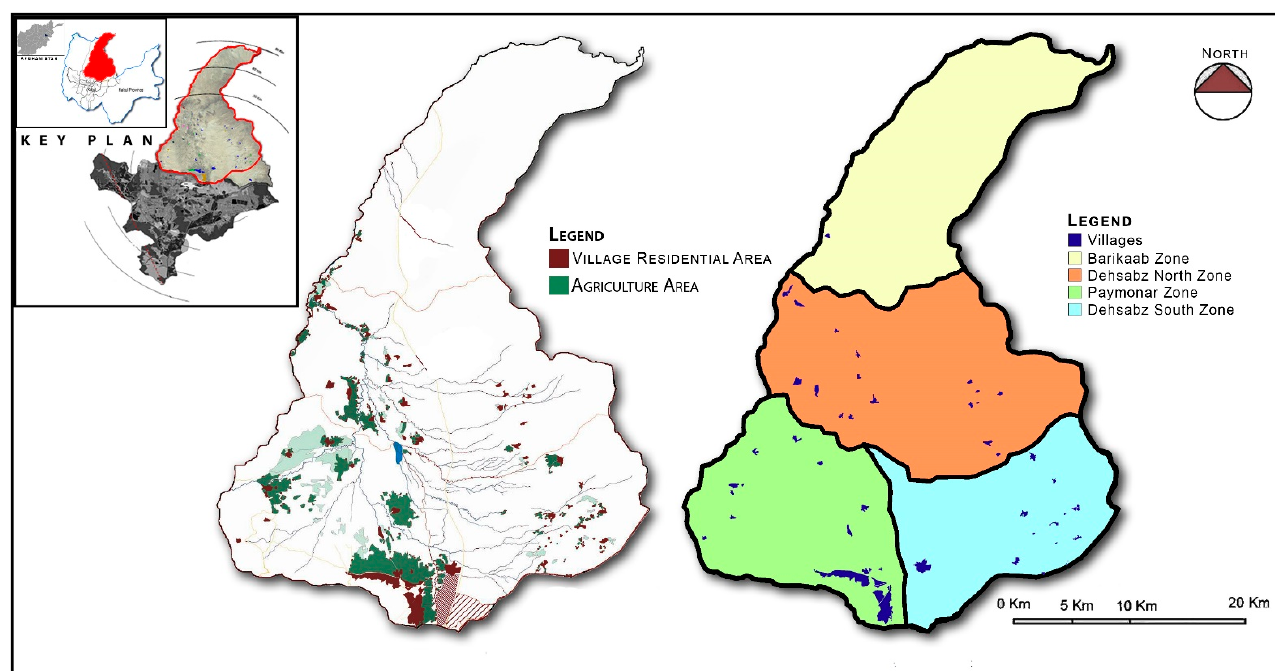
Figure 1. Different phases of KNC and the location of the villages under the KNC boundary. Table 1. The number of people living in villages. KNC Phases Barikaab